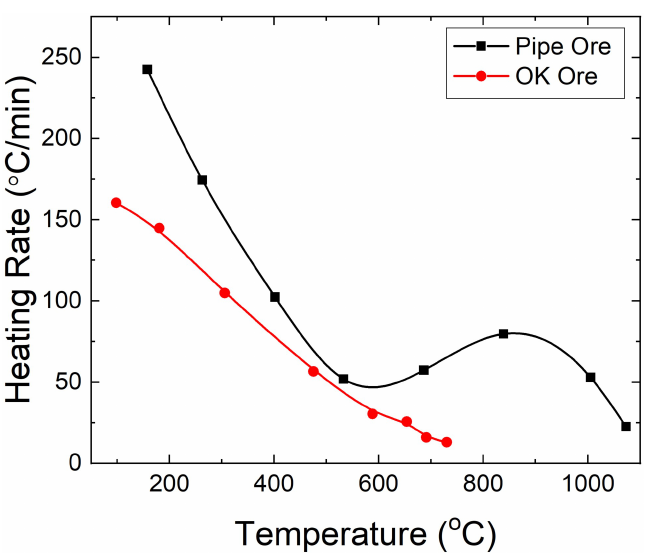
Figure 3. Heating rate upon exposure to microwave radiation versus temperature for Pipe and OK ores. The heating behavior of a material upon exposure to microwaves can be understood by examining the fundamental physics of microwave heating, and relating the observed heating behavior to intrinsic material properties. The heating rate of a material upon exposure to microwave radiation (Equation (2)) is directly proportional to the power dissipation (P(z)), and inversely proportional to the material density (ρ) and specific heat capacity (C p ).